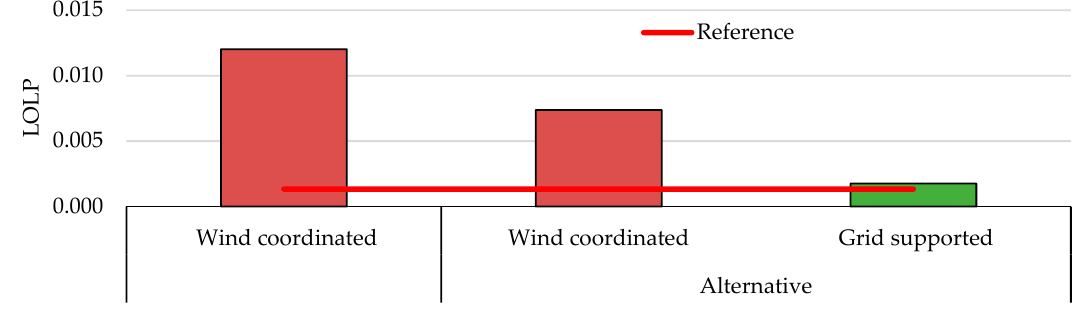
Figure 12. Alternative operational adequacy planning of wind and ESS integrated power system.